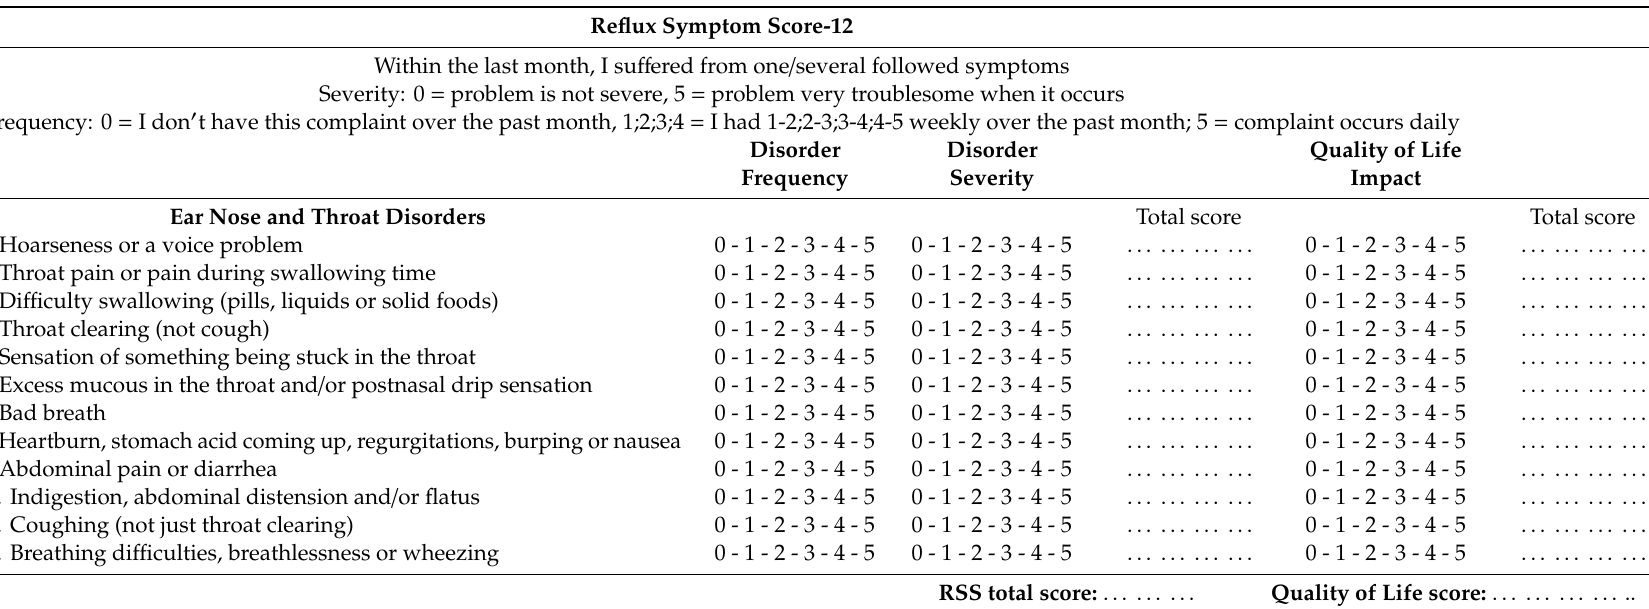
Table 1. Reflux Symptom